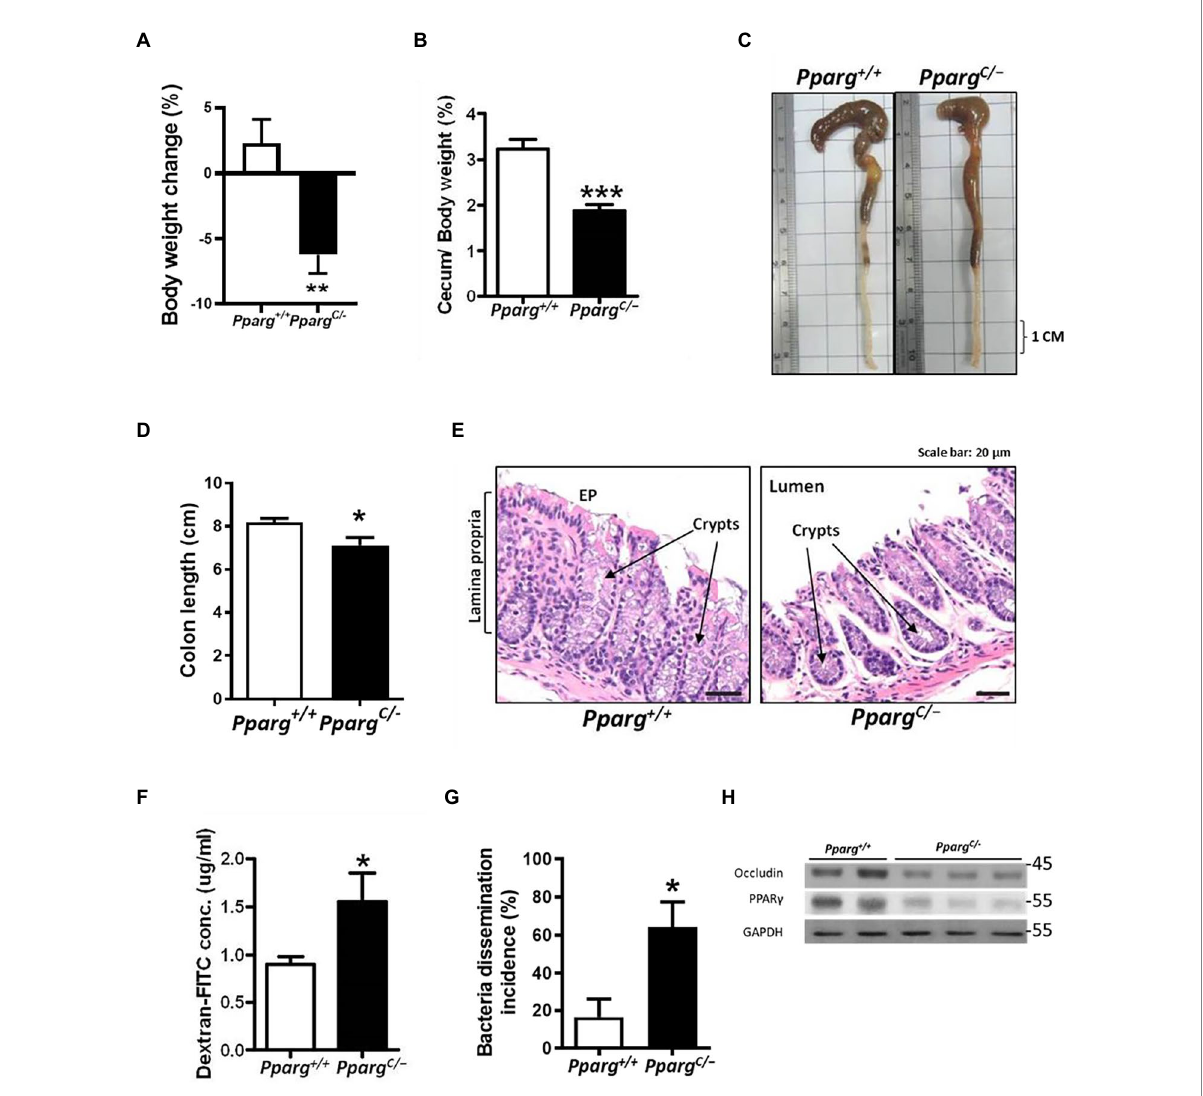
FIGURE 4 Comparison of pathologic severity and intestinal permeability during CDI between wild-type ( Pparg +/+ ) mice and PPAR- γ deficient ( Pparg C/ − ) mice. C. difficile were orally gavage to C57BL/6JNarl mice for 48 h. (A) Change in body weight after C. difficile challenge. (B) Change of cecum weight divided by body weight. (C) Gross view of the colon. (D) Quantification of colon length of Pparg +/+ and Pparg c/ − mice after CDI. (E) Histological changes of colon tisues were examined by H&E stain from Pparg +/+ and Pparg C/ − mice. (F) Translocation of dextran-FITC in mice compared with wild-type mice ( N = 9–14/group). (G) Percentage of bacterial dissemination to other organs in PPAR- γ deficient mice compared with wild-type mice. (H) Western blot analysis of PPAR- γ and occludin expression in colonic tissue of Pparg +/+ and Pparg C/ − mice after CDI. Values are expressed as mean ± SEM (*, p < 0.05; **, p < 0.01; ***, p < 0.001 relative to control group). All data are representative of three independent